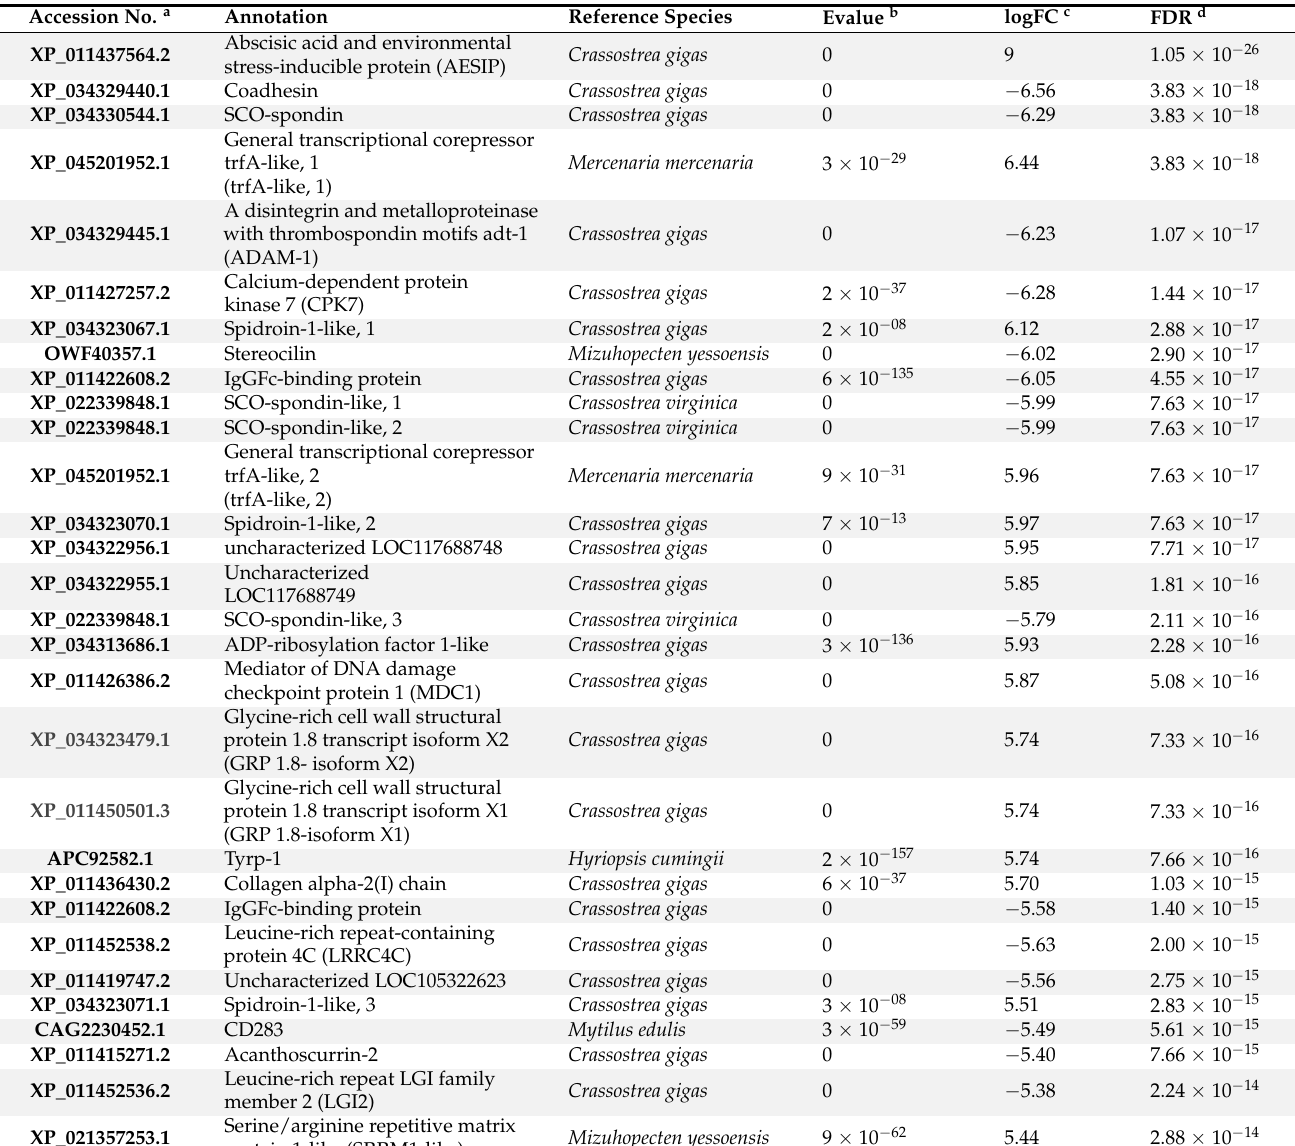
Table 3. Top thirty transcripts with differential expression between pre-settlement pediveliger larvae (Pedi) and postlarvae (PL) in Pacific oyster, C. gigas .